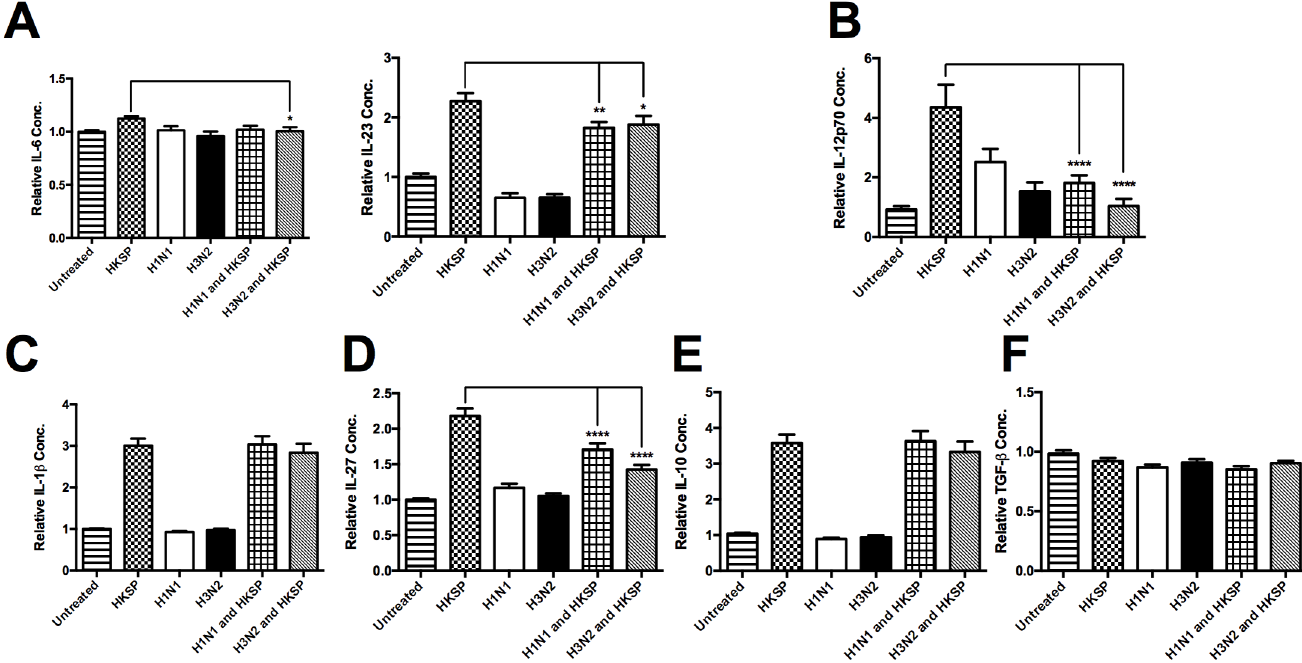
Fig 1. Live IAV attenuates innate cytokines in HKSP-treated cells. The levels of (A) IL-6, IL-23, (B) IL-12p70, (C) IL-1 β , (D) IL-27, (E) IL-10, and (F) TGF- β , secreted by CD14 + cells following 24 h treatment with HKSP, live H1N1 or H3N2 alone or in combination with HKSP (or untreated as a control) were determined by ELISA. Each column represents normalised mean cytokine levels + SEM of at least 3 experimental repeats of each treatment/donor. Each ELISA represents normalised results from multiple donors: (A) IL-6 (n = 5), IL-23 (n = 7), (B) IL-12p70 (n = 12), (C) IL-1 β (n = 11), (D) IL-27 (n = 10), (E) IL-10 (n = 9), and (F) TGF- β (n = 8). Statistical analyses were performed to compare cytokine levels in cells exposed to HKSP versus cells exposed to live H1N1 or H3N2 in combination with HKSP by fitting a One-way ANOVA to the data and using a Sidak test to adjust for multiple testing ( (cid:3) p < 0.05, (cid:3)(cid:3) p < 0.01, (cid:3)(cid:3)(cid:3) p < 0.001, (cid:3)(cid:3)(cid:3)(cid:3) p < 0.0001).